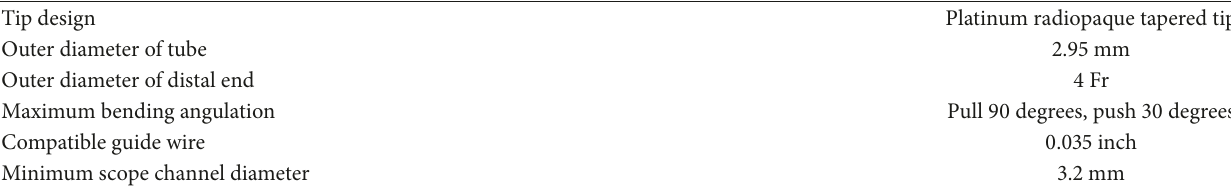
Table 1: Specifications of the Swing Tip.